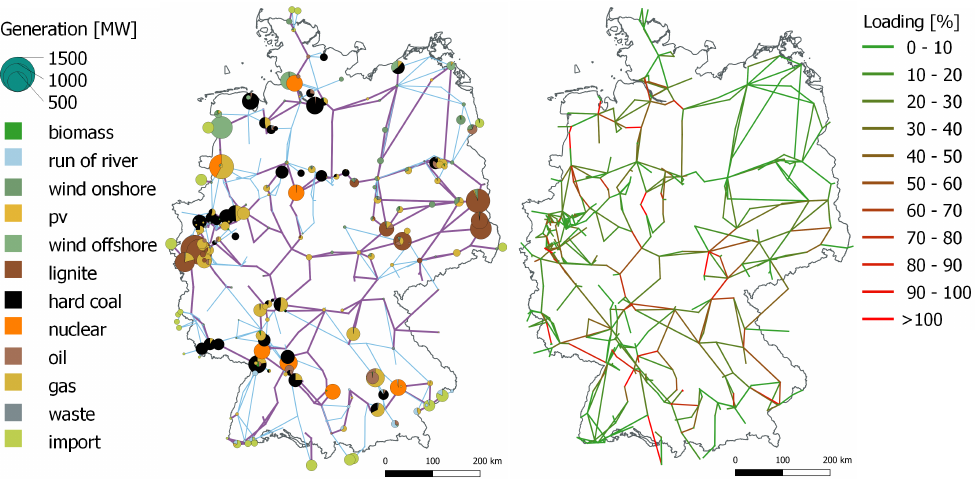
Figure 2. Geographical distribution of generation ( left ) and line loadings in a highly utilized state ( right ) of the EHV grid.